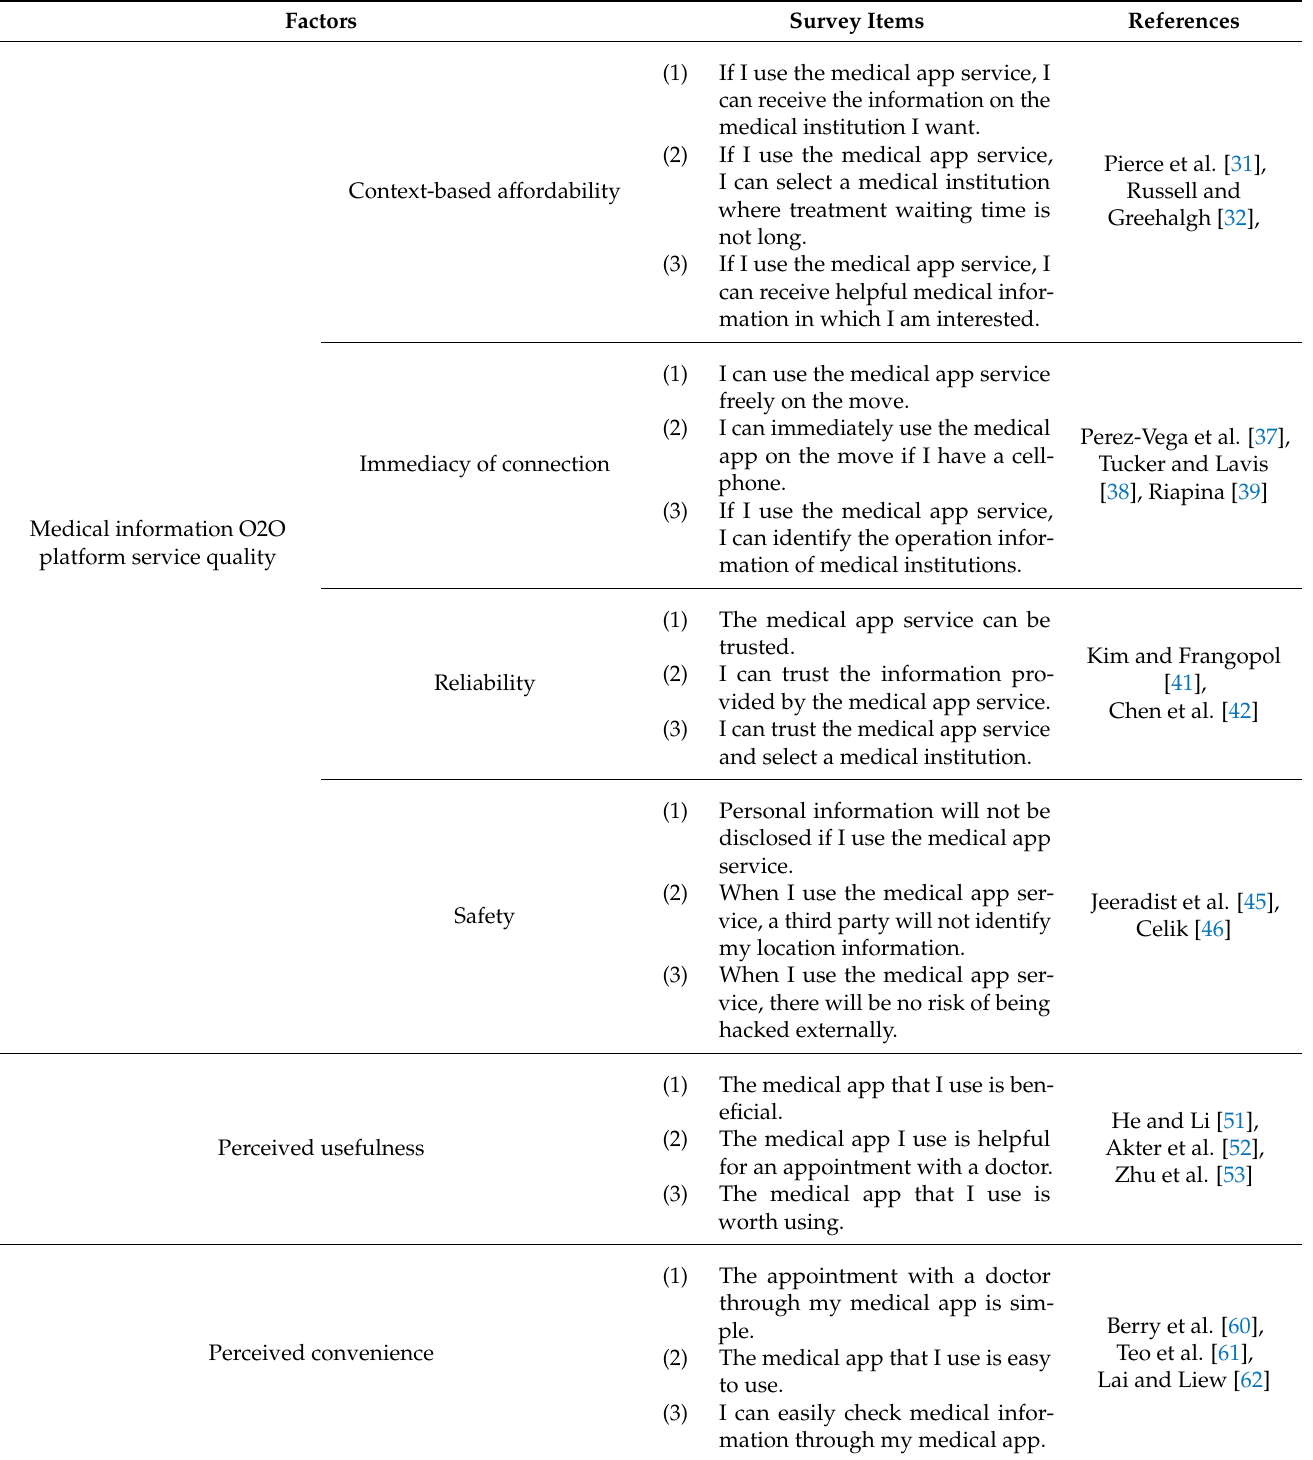
Table 2. Variable definitions and measurement